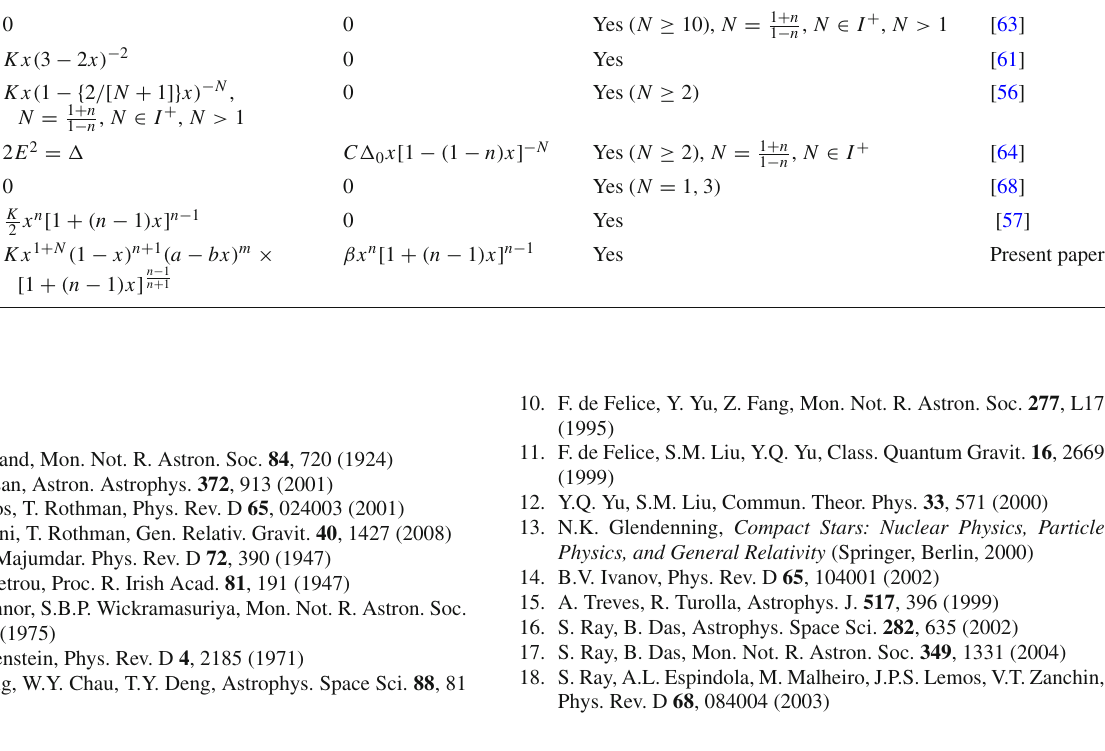
Table 8 List of regular behavior of d p / d ρ for the ansatz e ν( r ) = B ( 1 − x ) − n n Electric charge function (2 q 2 C / x 2